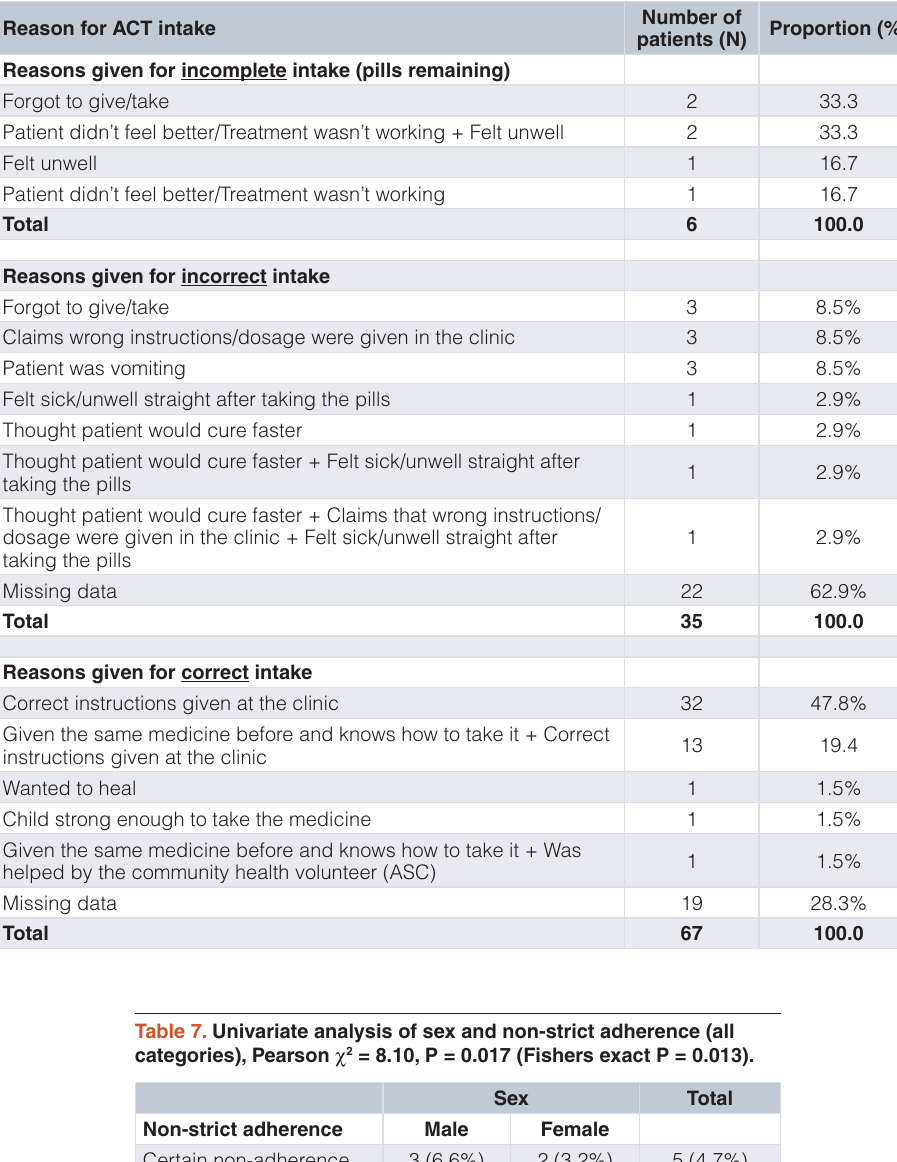
Table 6. Reasons given by patients for incomplete, incorrect and correct ACT intake. Reason for ACT intake